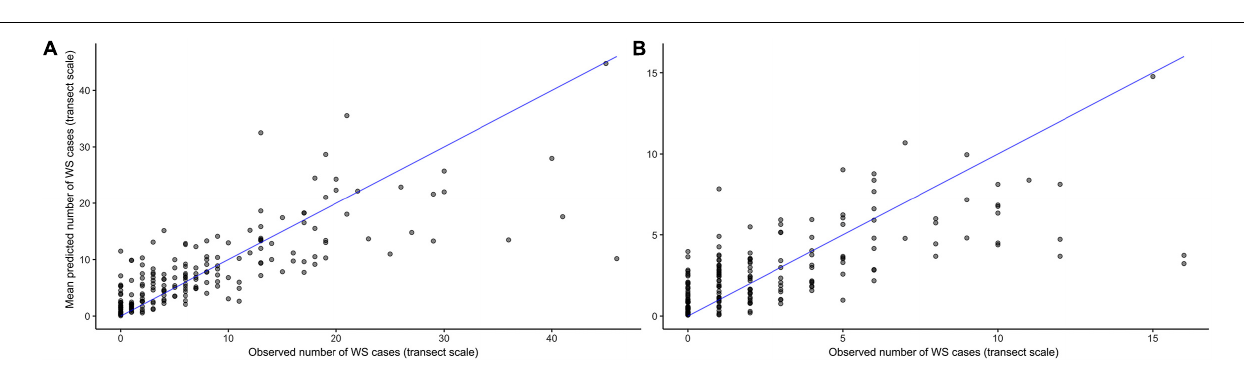
(Hypothesis Groups 7 and 8). While concurrent